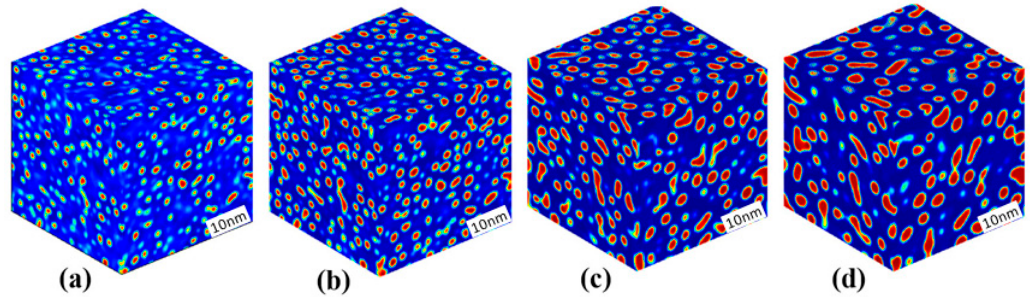
Figure 7. 3D morphology of the Cr-enriched α′ phase in the Fe-33 at % Cr alloy aged at 750 K, ( a ) t = 70 h; ( b ) t = 138 h; ( c ) t = 506 h; ( d ) t = 1152 h.